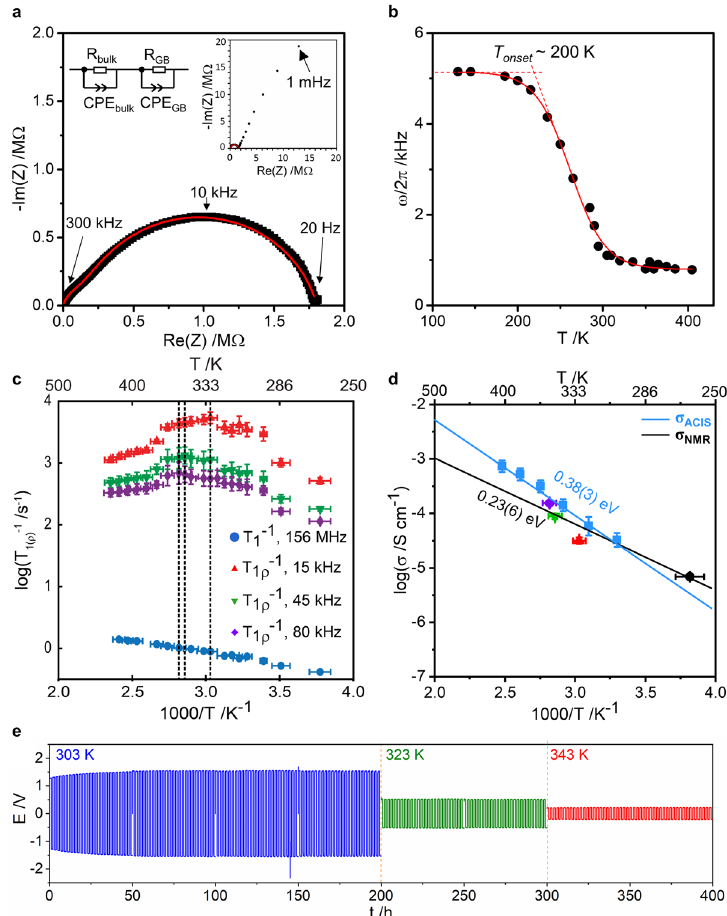
Fig. 4 Lithium conductivity and dynamics in Li 3.3 SnS 3.3 Cl 0.7 . a Room temperature (303 K) Nyquist plot of impedance response and the fi t (red line) using the equivalent circuit above, showing the two contributions to the conductivity, CPE constant phase element, R resistance, and GB grain boundary. Inset shows the impedance spectra over an extended frequency range. b Temperature dependence of static 7 Li NMR line width as a function of temperature. The solid line is a sigmoidal regression fi t and is a guide to the eye. Increase in Li motion starts at T onset . c Arrhenius plot of spin-lattice relaxation (SLR) rates in the laboratory frame (T 1 − 1 ) at a Larmor frequency of 156 MHz (blue circle) and in the rotating frame (T 1 ρ − 1 ) at spin-lock frequencies ω 1 /2 π of 15 (red triangle), 45 (green inverted triangle) and 80 kHz (purple diamond). The colored ticks on the upper x -axis represent the temperatures of the T 1 ρ − 1 maxima. The error bars associated with the temperature are calculated from the broadening of the isotropic peak of the chemical shift thermometer Pb(NO 3 ) 2 (Supplementary Methods), while the errors in T 1 − 1 and T 1 ρ − 1 are obtained from the output of the fi ttings of Supplementary Equations 2 and 3 respectively. d Arrhenius plot of the bulk conductivity measured by ACIS (blue circles) and calculated from NMR jump rates using Supplementary Equation 5 from line narrowing experiments (black circle, panel b) and SLR rates T 1 ρ − 1 (panel c) using the same color coding. The corresponding linear fi ts using an Arrhenius law are given in blue and black lines. The errors obtained in σ NMR were derived from the propagation of the various errors associated with Supplementary Equation 5. e Galvanostatic Li plating/stripping voltage pro fi le of a symmetric Li | Li 3.3 SnS 3.3 Cl 0.7 | Li cell measured at 10 µ A cm − 2 at 303, 323, and 343